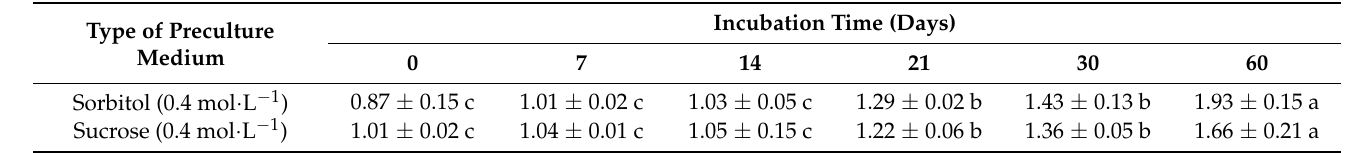
Table 5. Effects of the kind of preculture medium on the fresh weight of F. mandshurica embryogenic callus after cryopreservation by the slow cooling method.